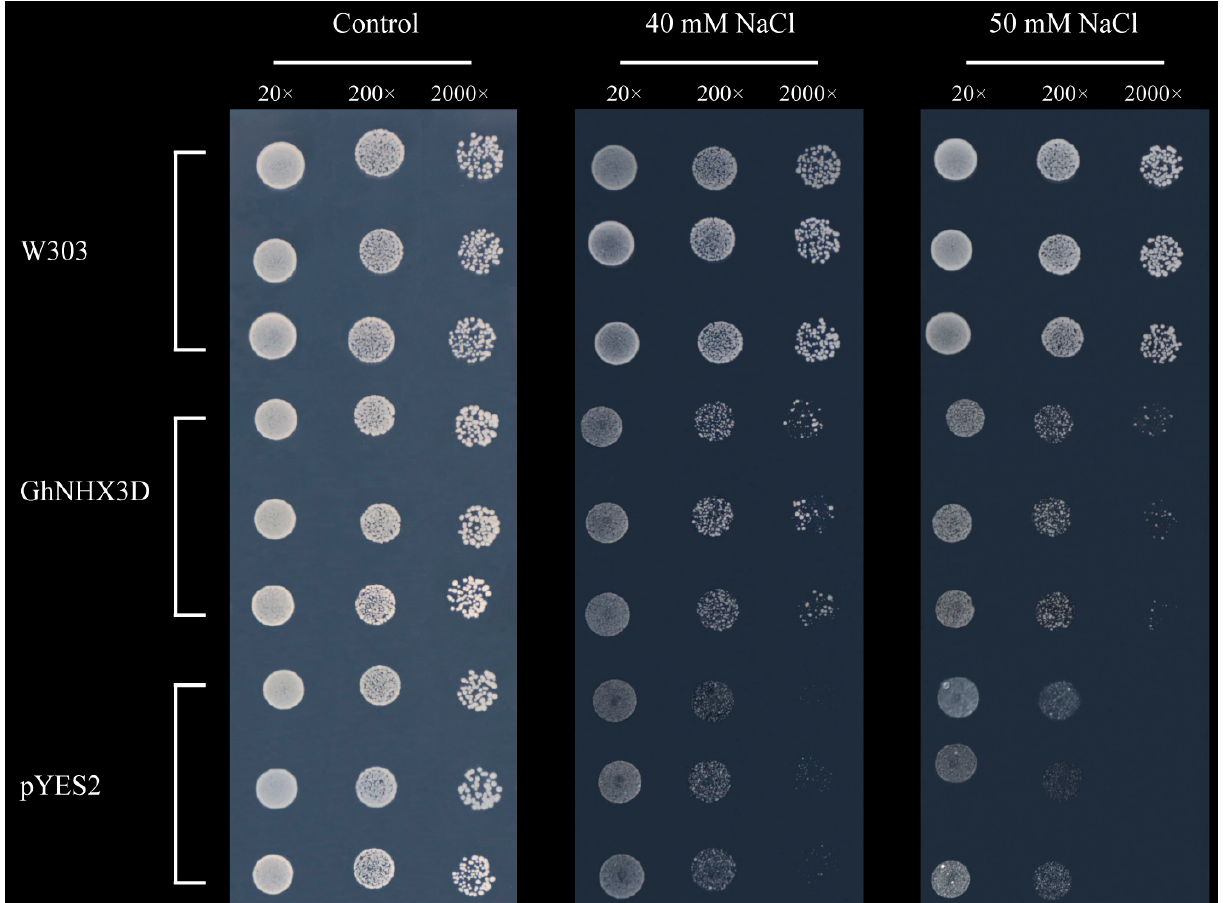
Figure 3. Relative transcript levels of GhNHX3D in cotton seedlings under salt stress. The salt concentration is shown on the x-axis; relative gene transcript levels are shown on the y-axis. Data are means ± standard deviation of three biological replicates. Significant differences compared with the 0 mM NaCl treatment (Student’s t -test): **, p < 0.01.